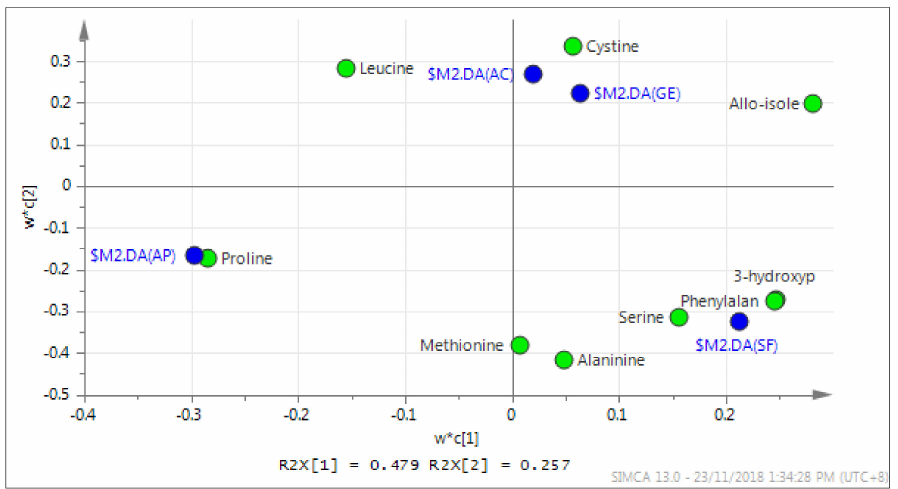
Figure 5. The score scatter plot of amino acids for all honey samples. The blue circle indicates the type of honey. AC = acacia honey, GE = gelam honey, SF = starfruit honey and AP = Apis